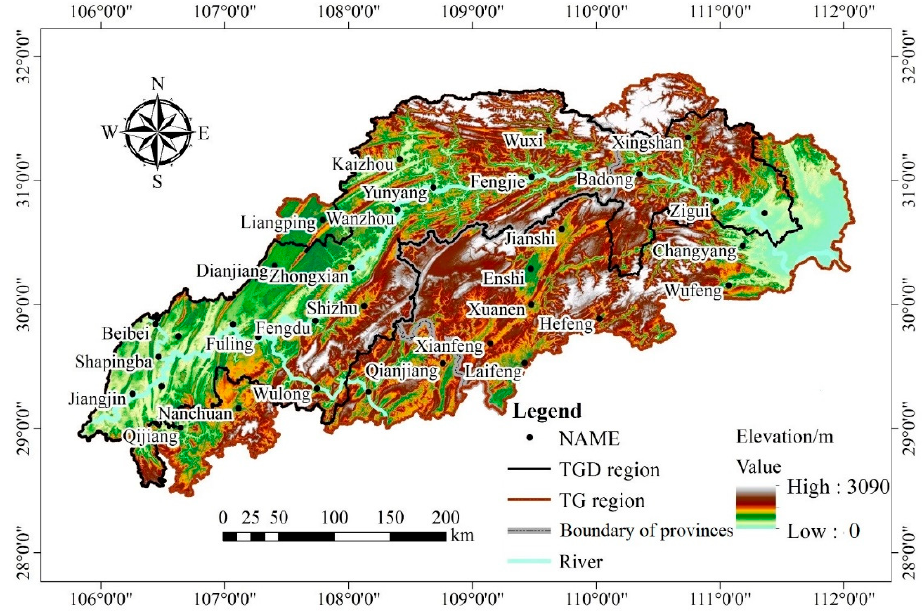
Figure 1. Elevation topography and meteorological station distribution in the TGRR.